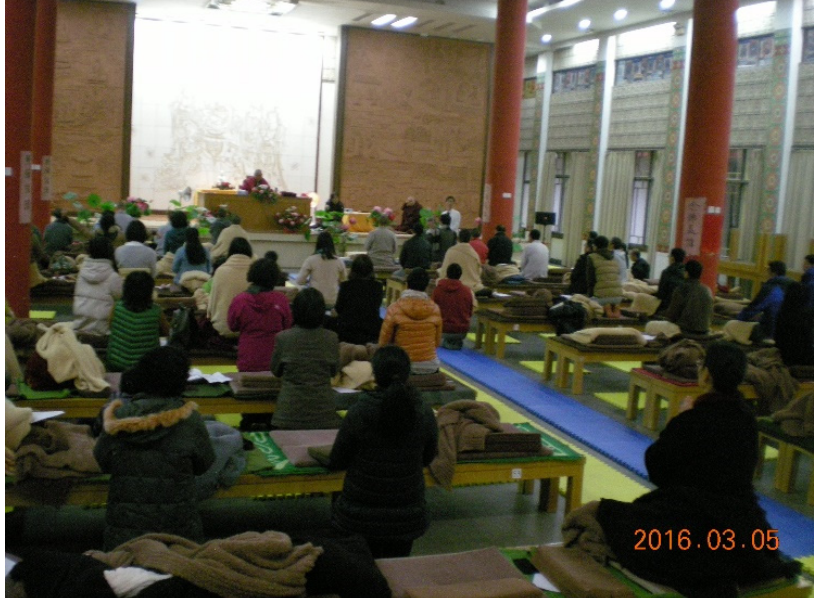
Figure 1. Monks, nuns, laymen and laywomen were practicing sitting meditation in the hall of Yunshan Monastery (taken by the author).